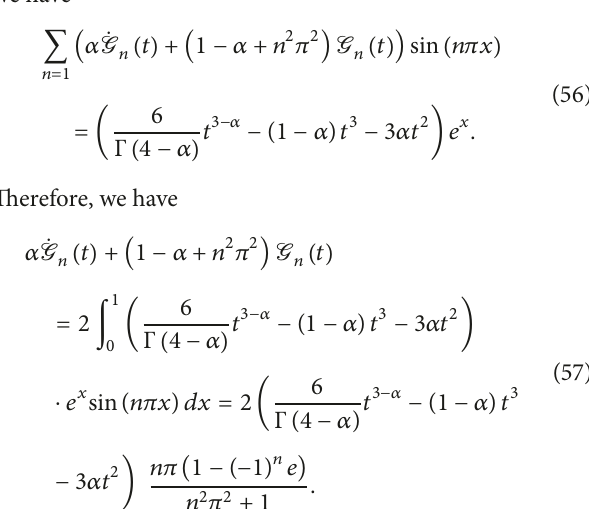
Table 5: Maximum norm relative errors of the proposed approxi- mate-analytical solution, NSFD method, and SFD technique for Example 7.